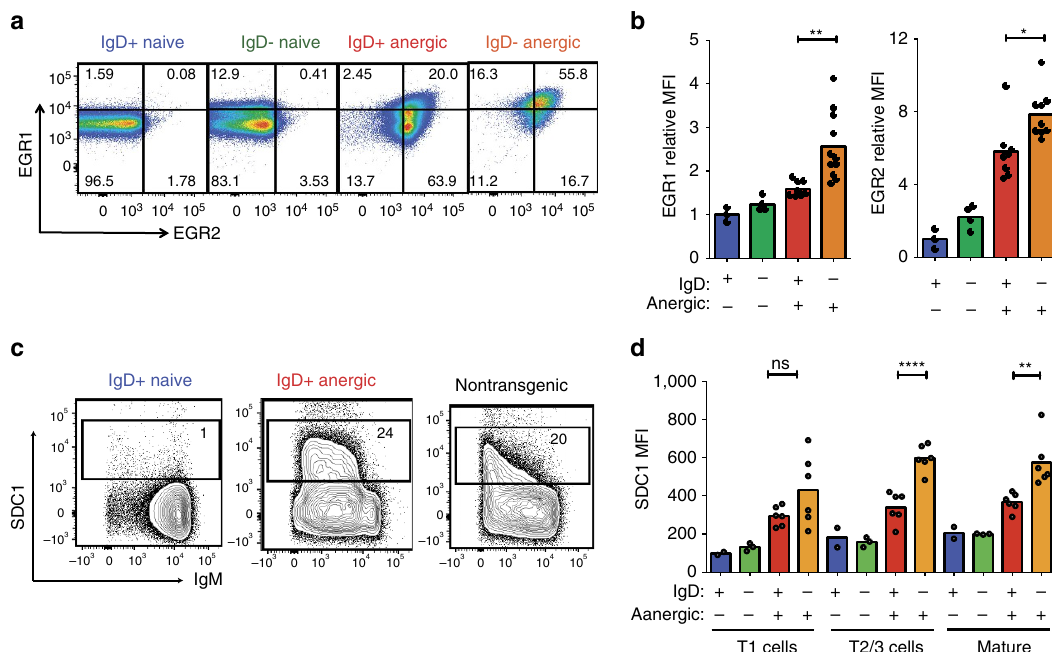
Figure 5 | Increased EGR1, EGR2 and SDC1 induction on anergic B cells lacking IgD. Flow cytometric analysis of HEL-binding B220 þ spleen B cells from MD4 and MM4 transgenic mice (IgD þ and IgD (cid:2) naı¨ve, respectively) and from MD4:ML5 and MM4:ML5 double transgenic mice (IgD þ and IgD (cid:2) anergic, respectively), gated as shown in Supplementary Figs 12 and 13. ( a ) Representative staining of permeabilised cells for EGR1 and EGR2, showing % HEL-binding B220 þ cells within the indicated quadrants. ( b ) EGR1 or EGR2 MFI in cells from individual mice pooled from two experiments, normalized to mean MFI in MD4 B cells from the same experiment. ( c ) Representative staining for surface SDC1 and % within the SDC1 þ gate (set using fluorescence minus one control) for IgD high B220 þ spleen cells from MD4, MD4:ML5 and C57BL/6 mice. ( d ) SDC1 MFI on HEL-binding B220 þ T1, T2/3 and mature follicular B cell subsets gated as in Fig. 1f. Dots show data from individual mice pooled from two experiments, and columns show means. Statistical analysis by ANOVA with Sidak’s multiple comparisons test of selected pairs: ns, not significant; **** P o 0.0001; ** P o 0.01; * P o